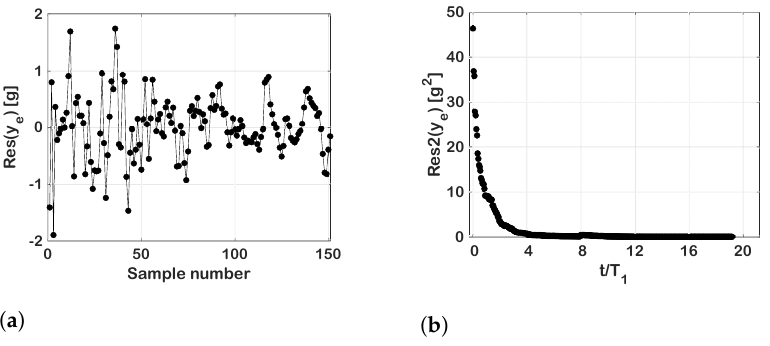
Figure 4. Example of residuals and summed squared residuals for the fitted functions shown in Figure 3: ( a ) residuals for the first bin; ( b ) summed squared residuals for all